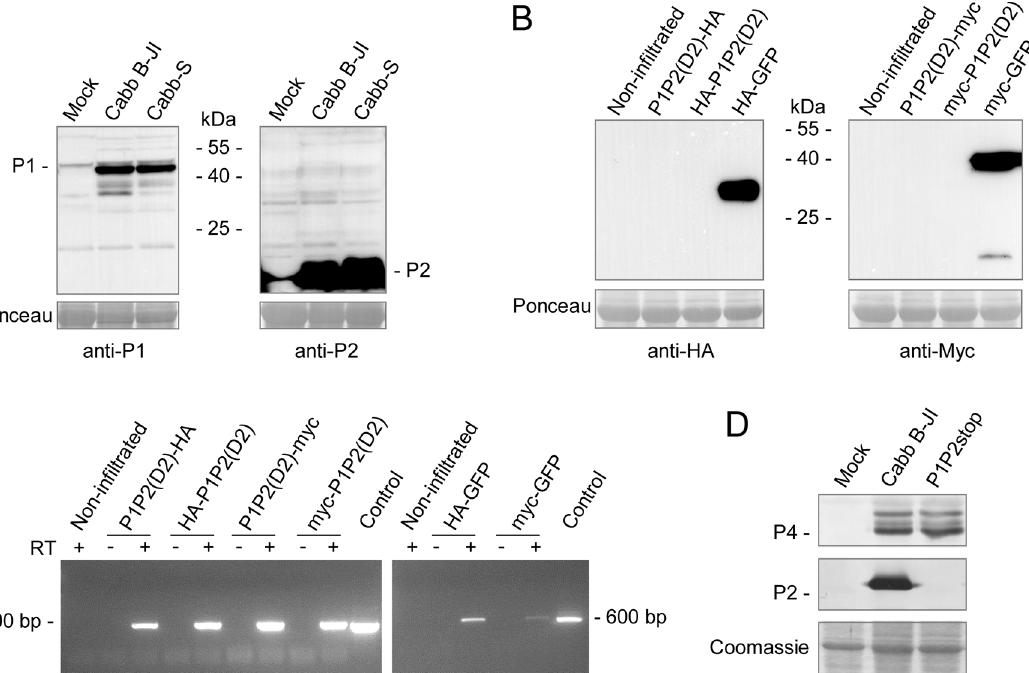
Fig 3. P1P2 fusion proteins are unstable in plants, both in a viral context and in transient expression assays, and are dispensable for infectivity. (A) Immunodetection of P1P2 fusion proteins in CaMV Cabb B-JI- or Cabb-S-infected turnip plants. Total proteins were analyzed by SDS-PAGE and western blotting was performed with anti-P1 and anti-P2 polyclonal antibodies. (B) Immunodetection of HA- or myc-tagged P1P2(D2) protein upon Agrobacterium tumefaciens -mediated transient expression assay in Nicotiana benthamiana leaves. Total proteins were extracted from agroinfiltrated leaves and the presence of P1P2(D2) fusion protein was assessed by western assays with anti-HA or anti-myc antibodies. Leaves agroinfiltrated with HA- or myc-GFP expression vectors were used as positive controls. Blots in (A) and (B) are overexposed deliberately to maximize chances of detection of P1P2 proteins. (C) Tagged-P1P2(D2) and GFP transcripts were assessed by RT-PCR on total RNA from infiltrated leaves. The recombinant plasmid pP1P2(D2) used for expression of the fusion protein in E . coli and pCK-EGFP [27] were used as controls. (D) Immunodetection of viral proteins P2 and P4 in systemic leaves of Cabb B-JI- or P1P2stop-infected turnip plants at 21